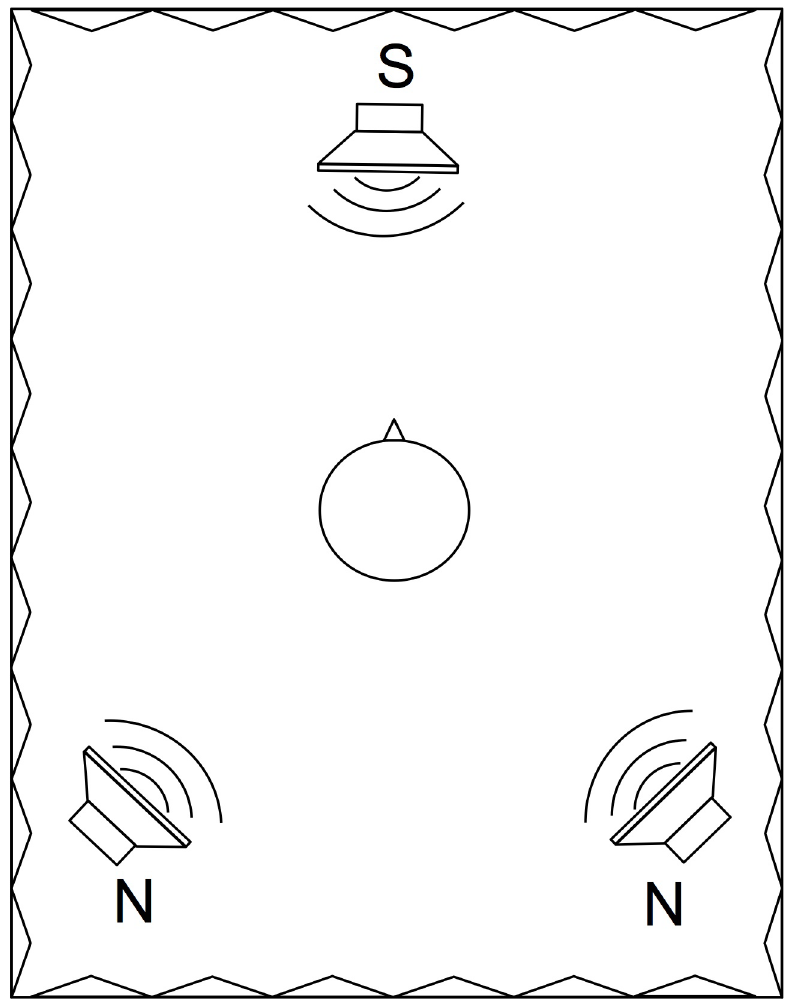
Fig 1. Experimental setup. All loudspeakers were placedin the horizontalplane approximately at ear height. Speech(S) was presented from 0˚ azimuth, noise sources (N) were placedat ± 135˚azimuth. The distance betweensoundsources and the center of the listener’s head was 130